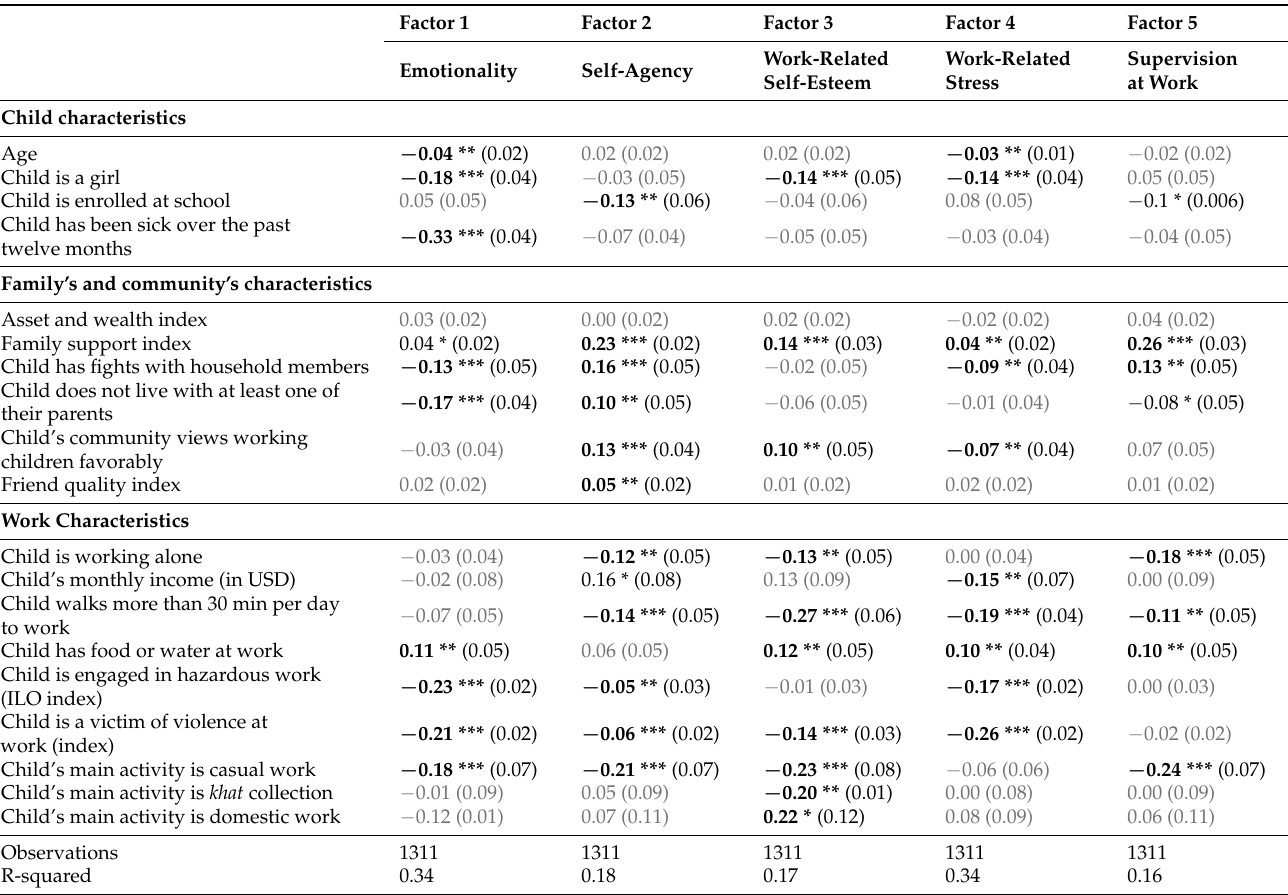
Table 2. Association between child, family, community, and work characteristics and child workers’ psychosocial wellbeing: a linear regression analysis. Factor 1 Factor 2 Factor 3 Factor 4 Factor 5 Emotionality Self-Agency